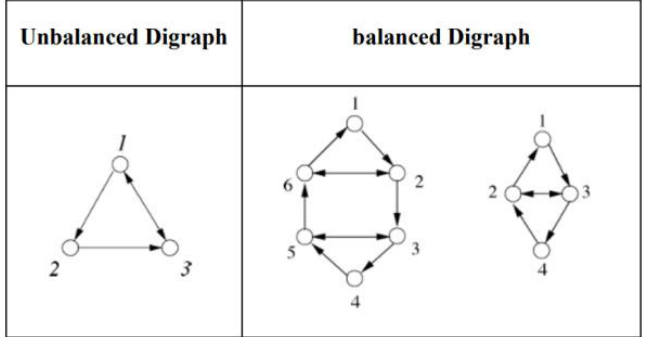
Figure 17. Examples of Balanced and Unbalanced Digraphs.